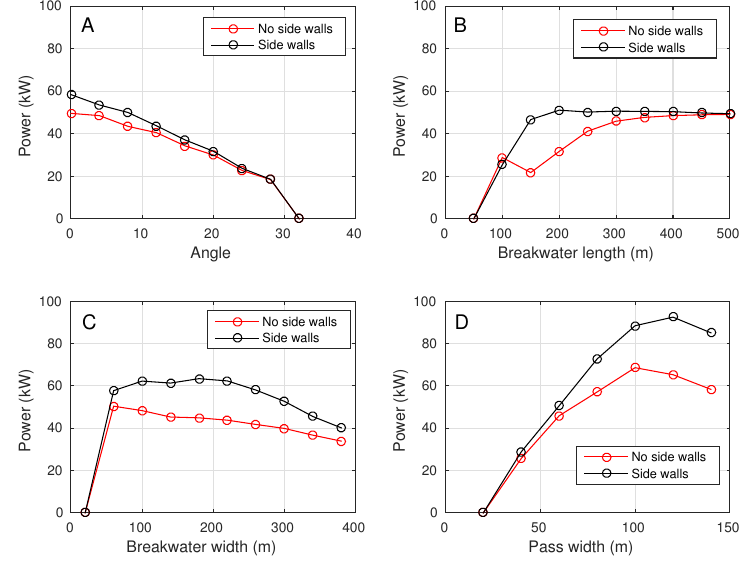
Figure 5. Power production for four parameters, with and without side walls. ( A ) Breakwater angle. ( B ) Breakwater length. ( C ) Breakwater width. ( D ) Reef pass